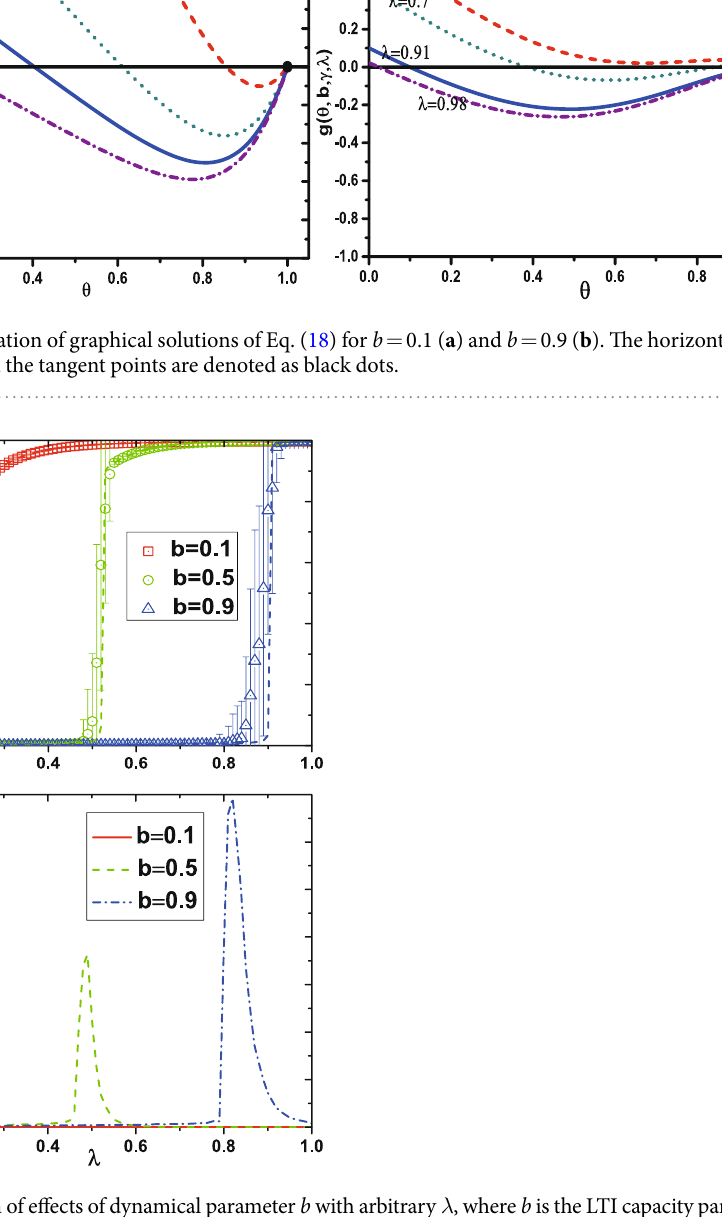
II corresponding to the peak. c